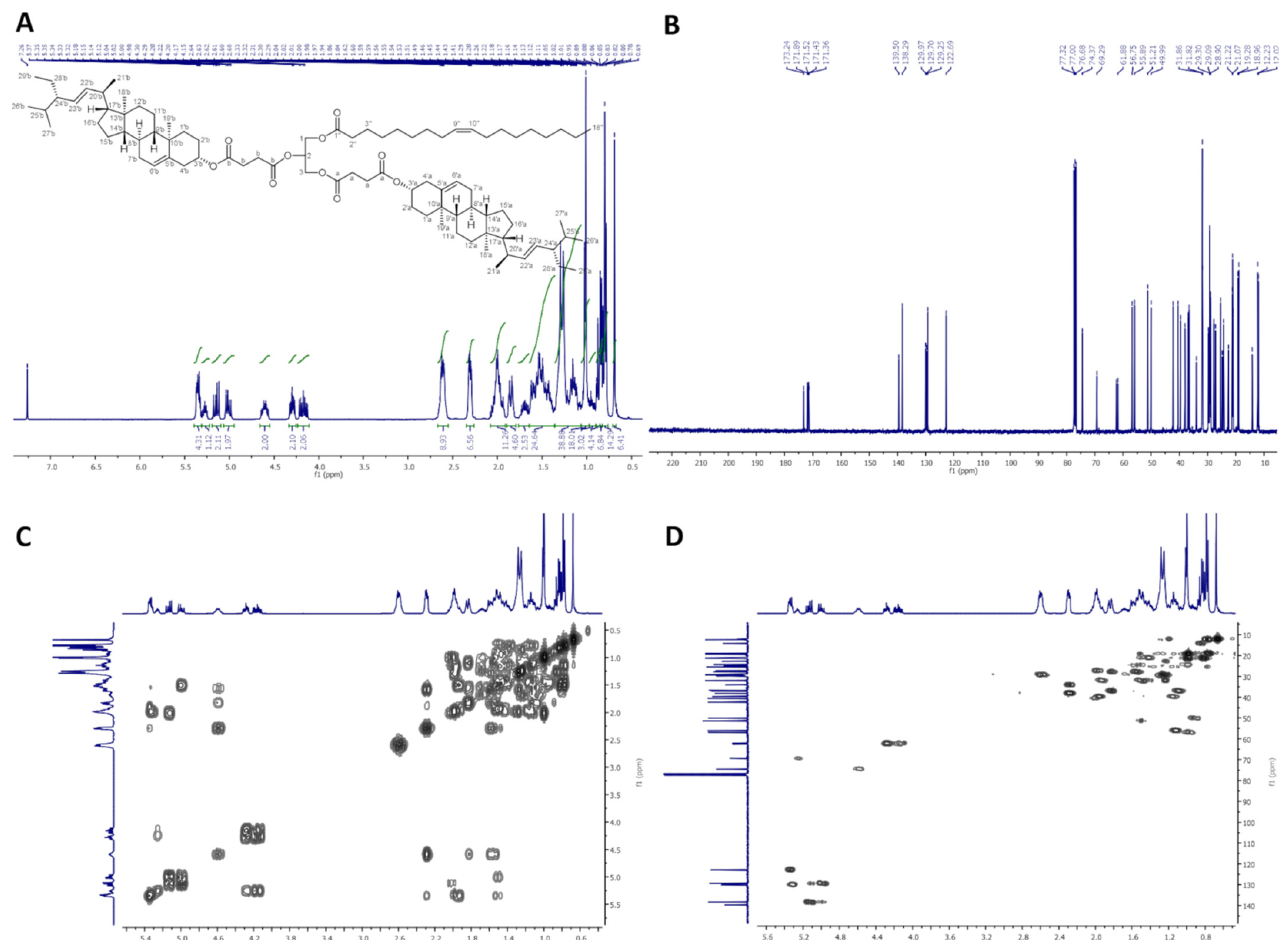
Figure 3. NMR spectra of dStigS-OA: ( A ) 1 H-NMR (400 MHz, CDCl 3 ), ( B ) 13 C-NMR (100 MHz, CDCl), ( C ) COSY and ( D ) HMQC.